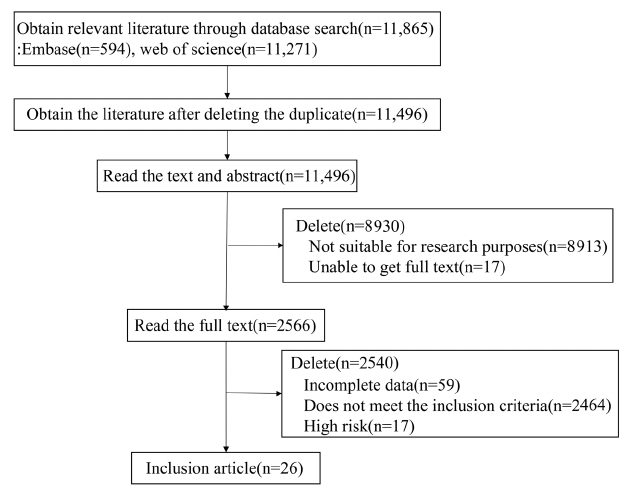
Figure 1. Literature screening process and flow.